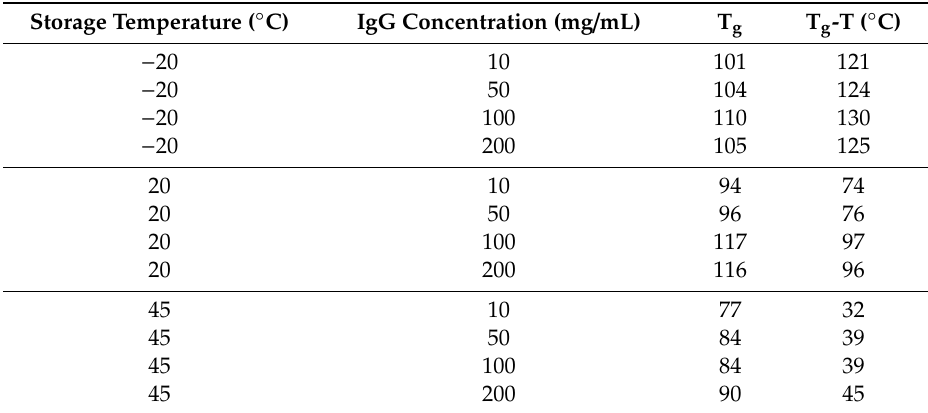
Table 2. Comparison of difference in storage temperature T and glass transition temperature T g after 12 months of storage.